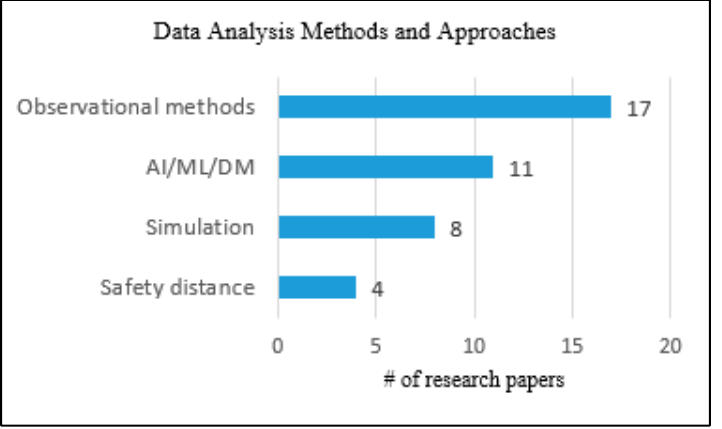
Figure 12. Data analysis methods and approaches.